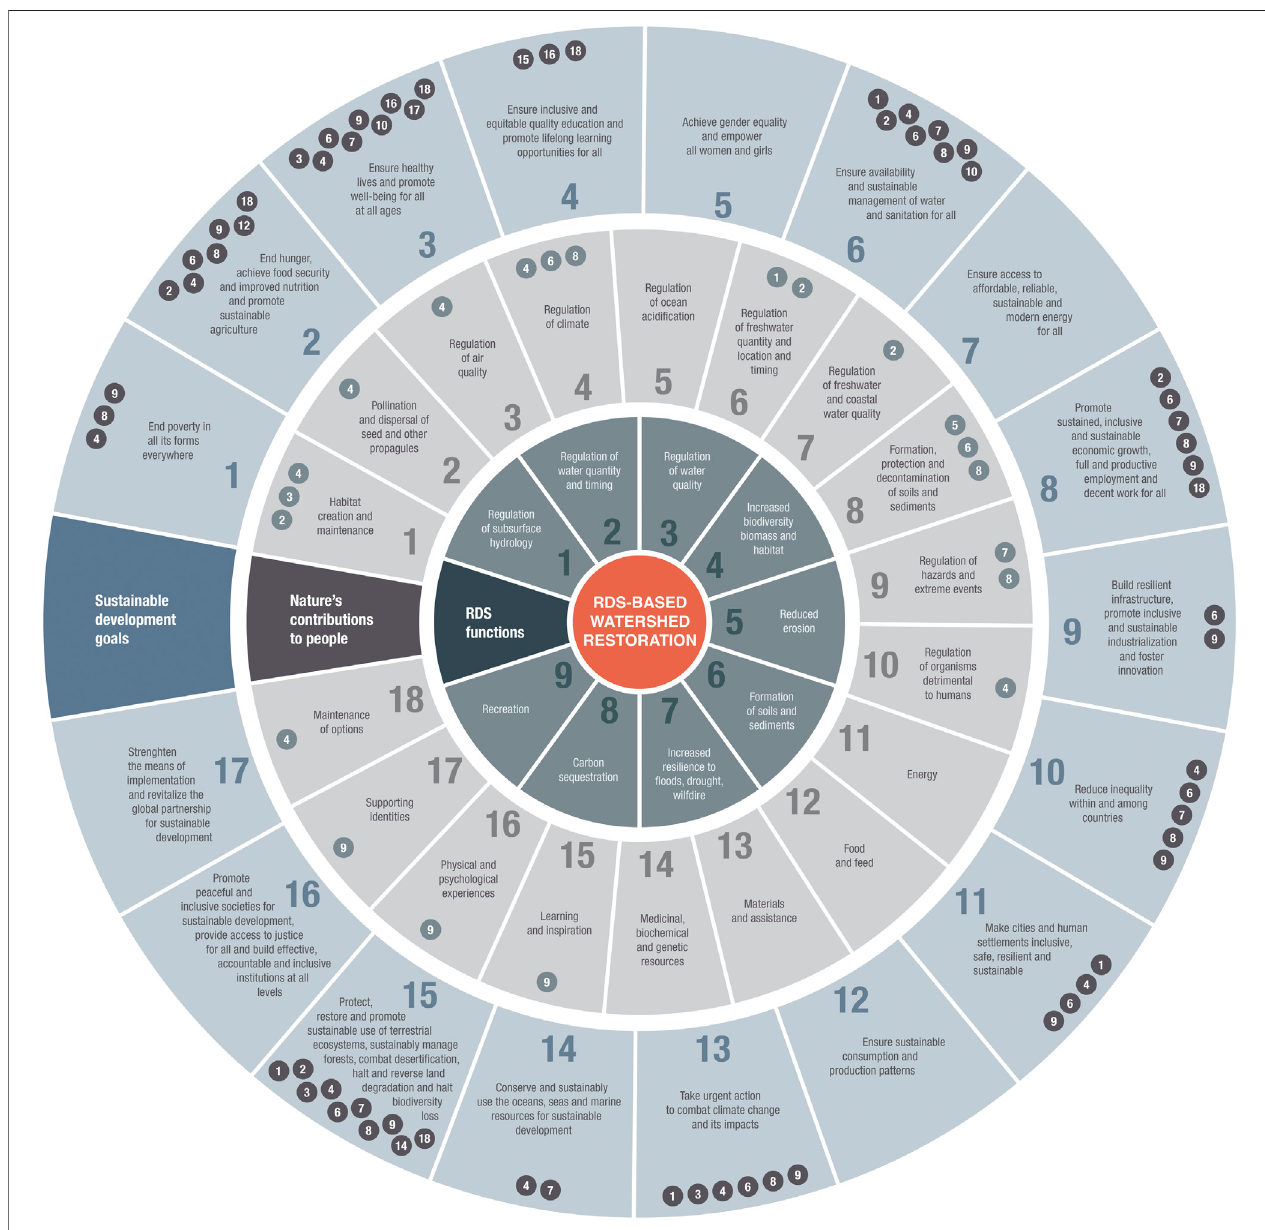
FIGURE 2 | Summary of the impact of RDS-based watershed restoration on ecosystem functions, on nature ’ s contributions to people (NCPs), and on the United Nations Sustainable Development Goals (SDGs), showing the impact of each function on each NCP, and the contribution of the NCPs to each of the SDGs. Figure adapted from similar fi gure by Smith et al.